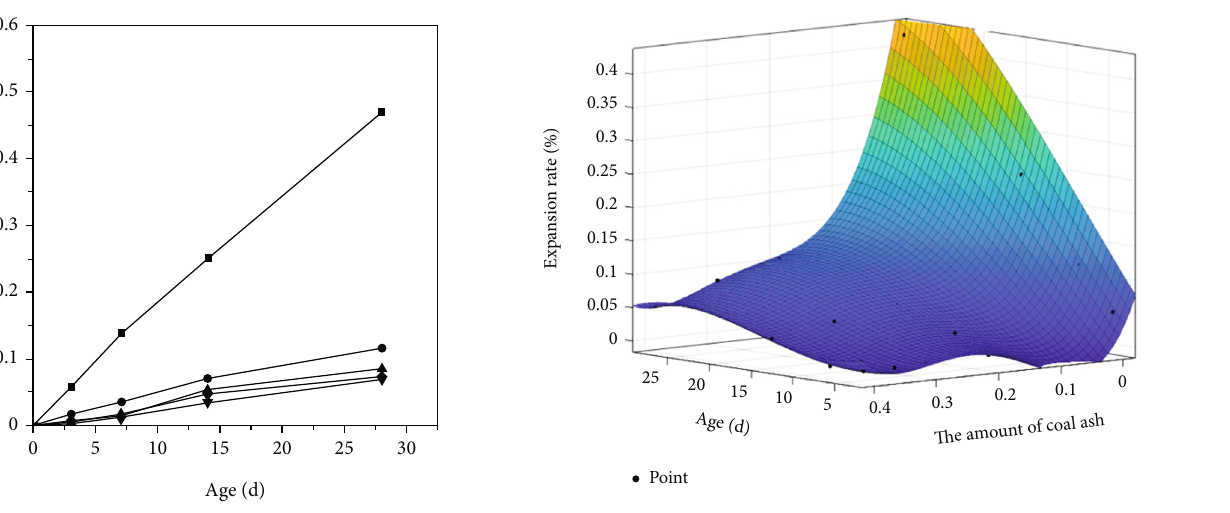
Figure 15: Quartic fi tting diagram of coal ash content, age, and expansion rate (cement alkali content 1.50%).